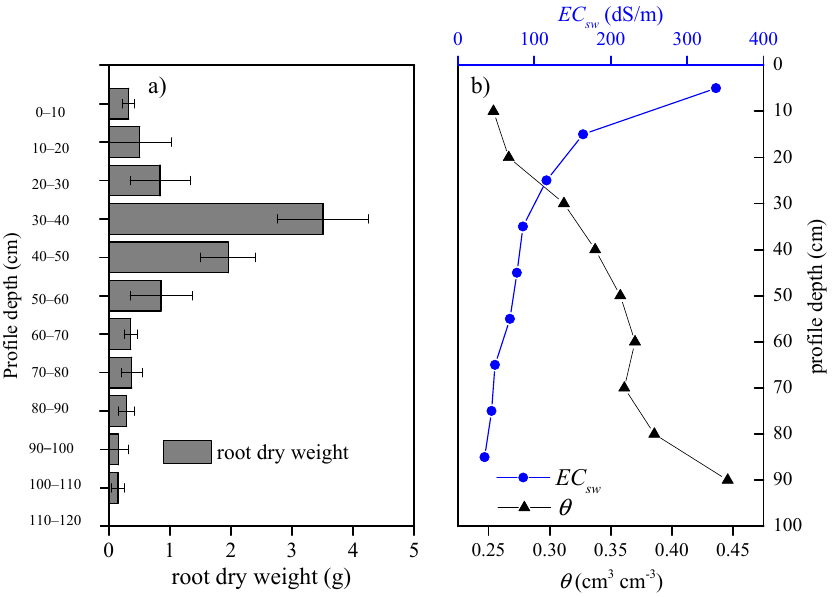
Figure 1. Graphical representation of ( a ) the root distribution of Chinese tamarisk measured at the start of the 2012 growing season and ( b ) the average value of soil water ( θ ) and EC sw during the 2012 growing